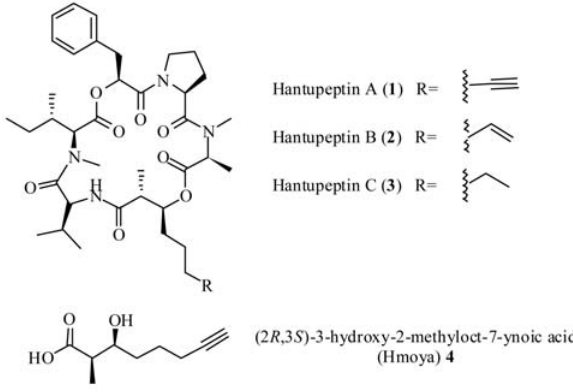
Figure 1: Structures of Hantupeptins